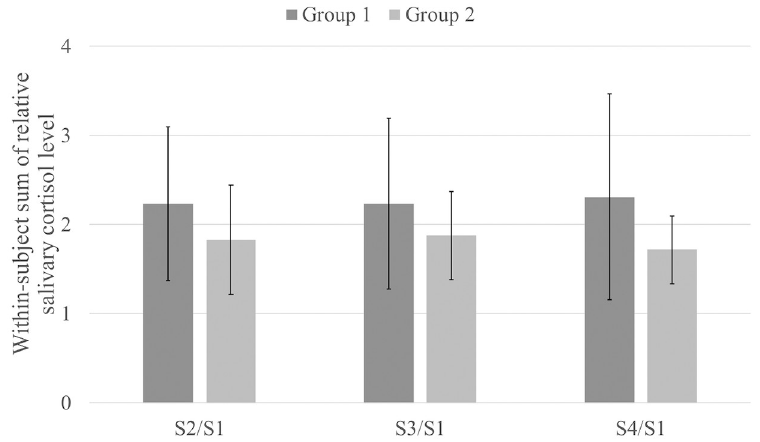
Fig 5. The within-subject sum of the changes in salivary cortisol levels on Day 1 and Day 2.